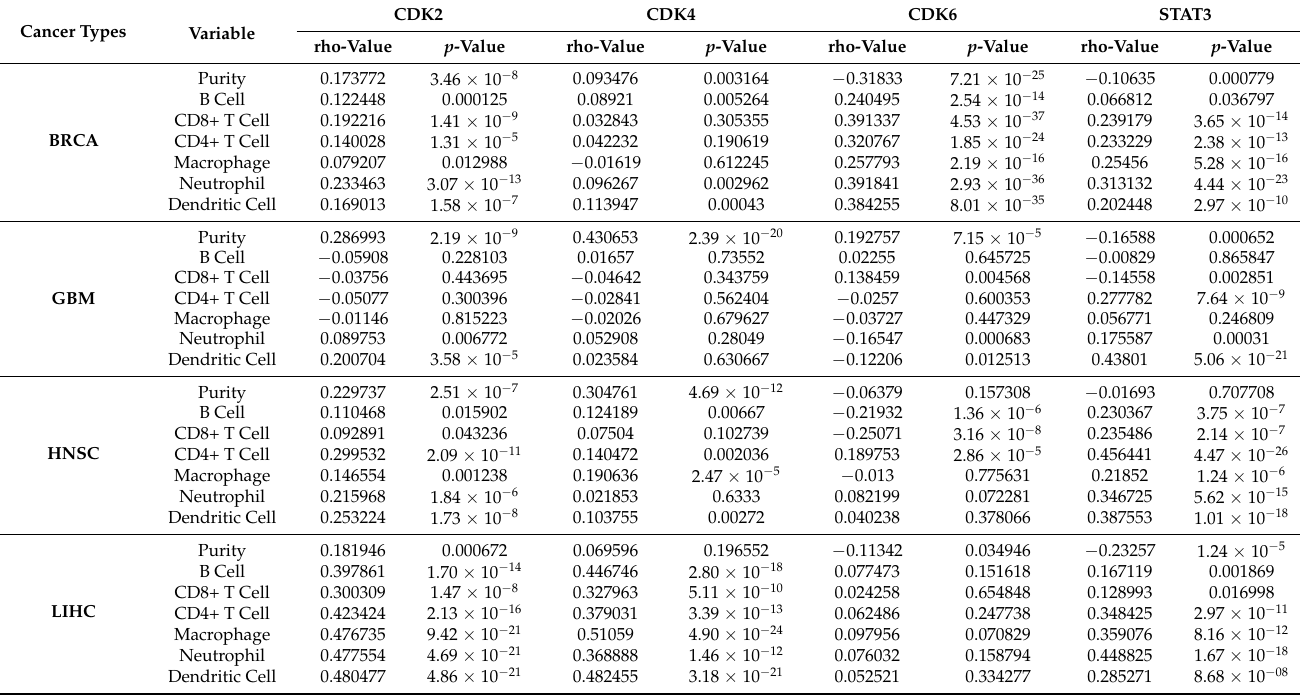
Purity-corrected partial Spearman’s rho value and statistical significance of the correlations of STAT3/CDK2/CDK4/CDK6 expressions with immune infiltration level in diverse cancer types. Cancer